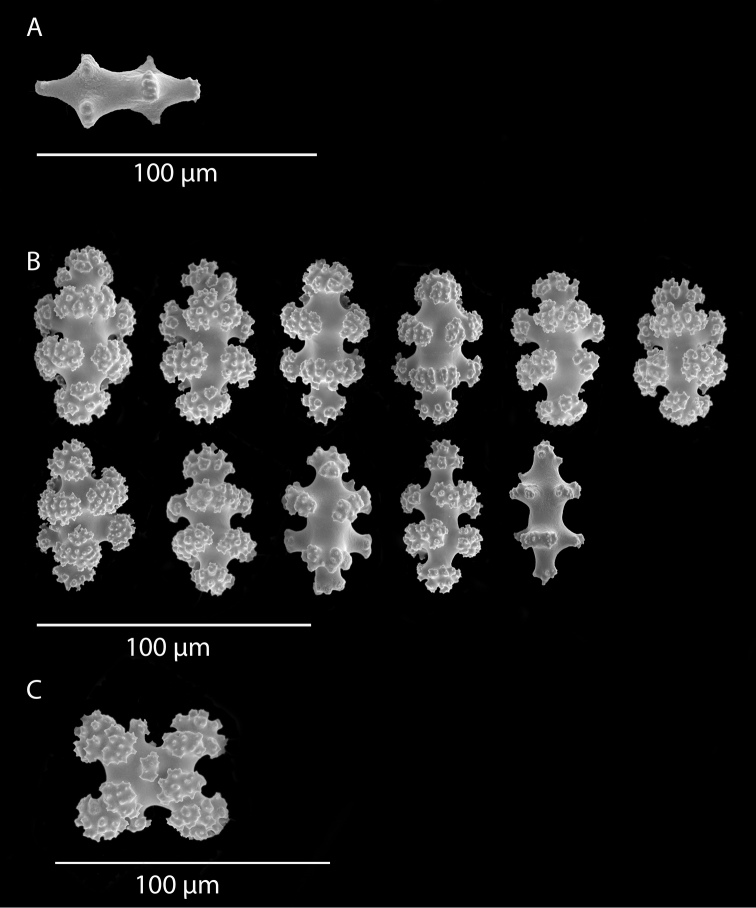
Leptogorgiaflexilis, SBMNH 422941, SEM image. Sclerite color deep orange. A Anthocodial sclerite B Sclerites of coenenchyme (last of which may actually be an anthodocial sclerite) C Quadriradiate from coenenchyme. Images match those shown in Breedy and Guzmán 2007 (fig. 30).